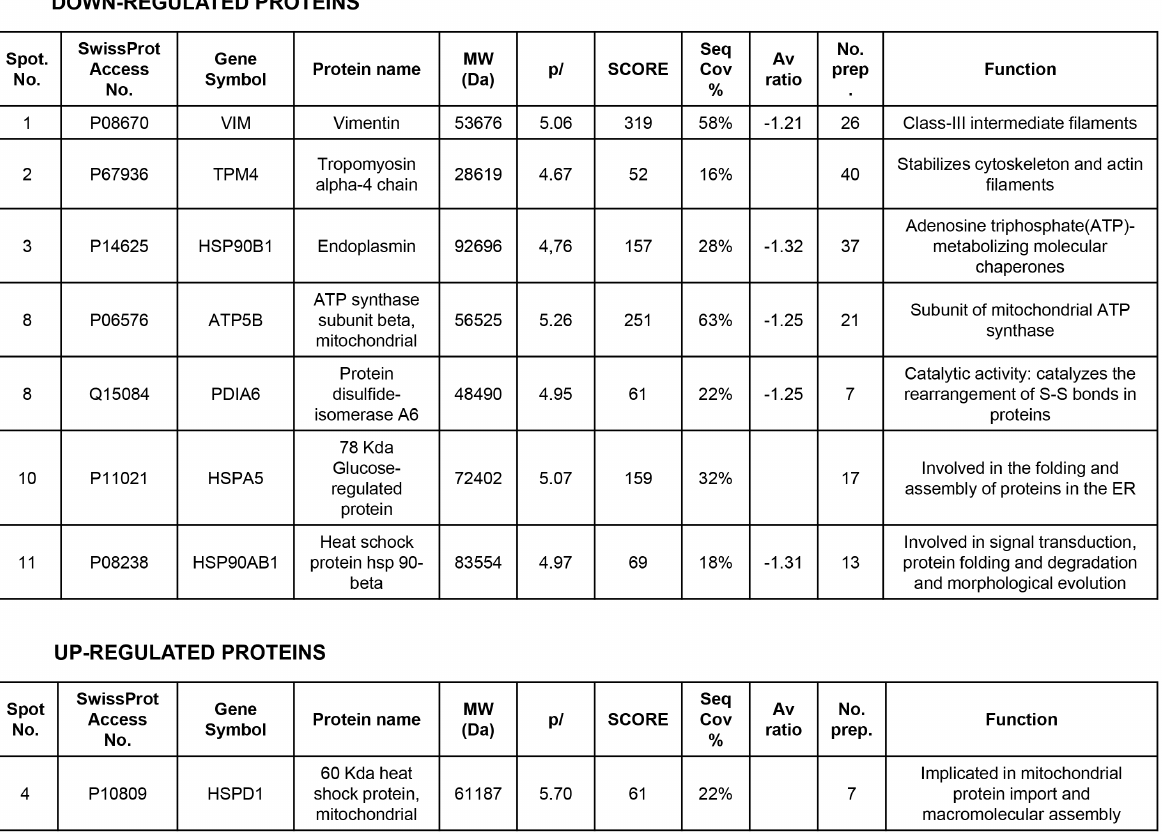
Figure 2. Proteins differentially expressed and identified by mass spectrometry analysis in HUVEC. The level of expression of various proteins in HUVEC was altered following PARP inhibition as determined by 2D-DIGE, and the proteins were positively identified using mass spectrometry analysis. Of particular interest for this study was vimentin, the major structural protein of intermediary filaments (spot 1). Expression of this protein was decreased in HUVEC following PARP inhibition. The proteins were identified by MALDI-TOF. Sequence coverage (%) and number of peptides were identified with =1% FDR (false discovery rate cut-off against decoy-concatenated randomized database). Coverage and score was determined using the MASCOT algorithm. The average ratio of protein expression between the control and cells treated with the PARP inhibitor DPQ was determined in HUVEC.